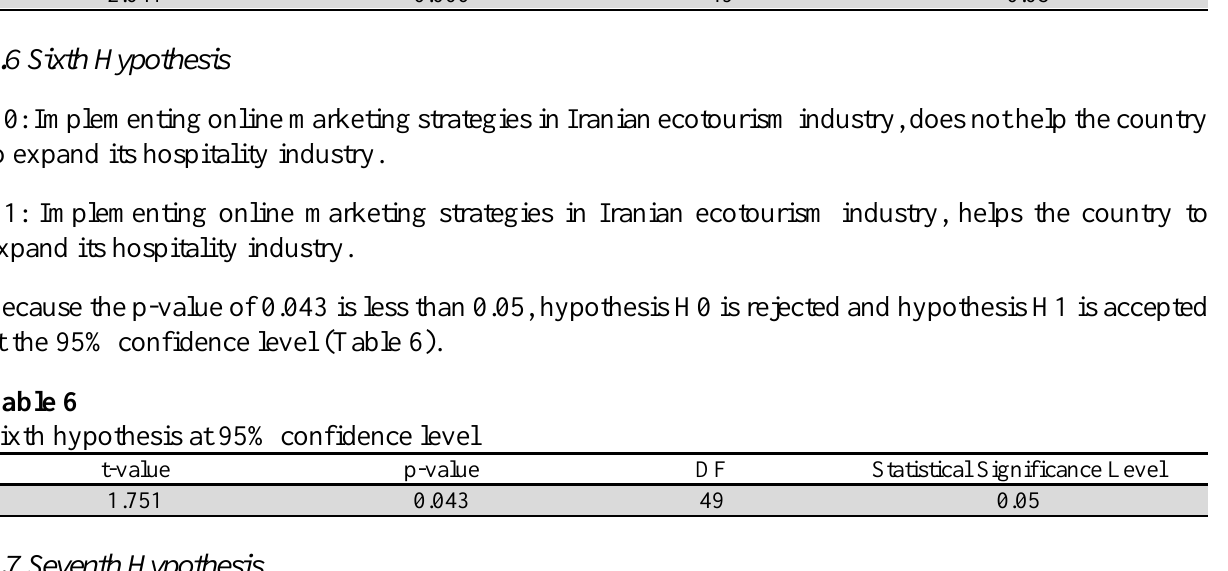
Fifth hypothesis at 95% confidence level t-value p-value DF Statistical Significance Level 2.641 0.006 0.05